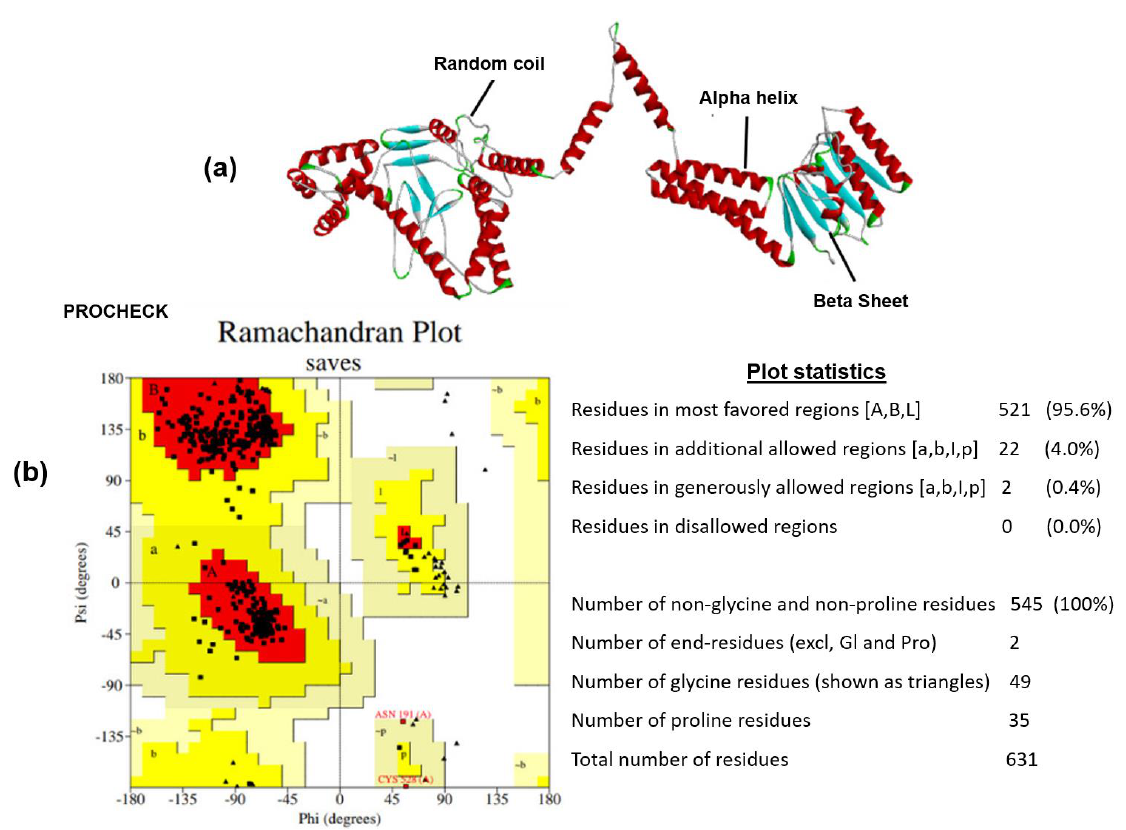
Figure 3. Validation results for the designed tertiary structure of the peptide vaccine construct. ( a ) Three-dimensional structure with highlighted alpha helix, beta sheet, and coil structures. ( b ) Ra- machandran plot indicating 95.6% residues in most favored